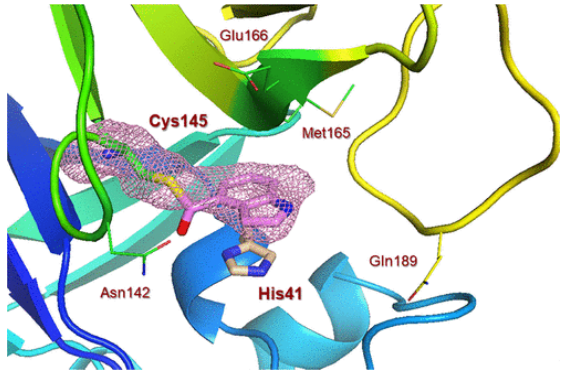
Figure 24. X-ray structure of SARS-CoV-2 3CLpro bound with compound 227 at 1.65 Å. Starˇcevi´c et al. [102] reported the synthesis of 2-substituted-5-amidino-benzimidazoles 230a – 230c from the reaction of 1,2-phenylenediamine 228 and picolinaldehyde 229 . All compounds possessed excellent antiviral activity against coxsackievirus B5 and echovirus 7, with EC 50 values of 0.33–56.7 µ M (Scheme 53, Table 15).